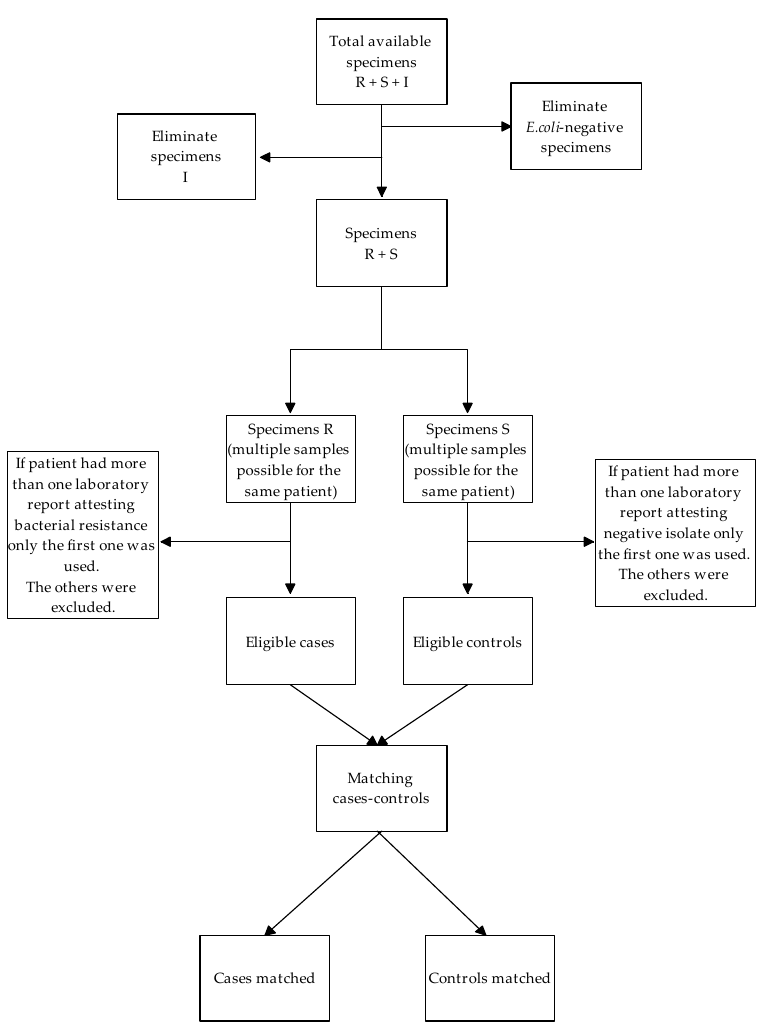
Figure 3. Flow diagram of included cases and controls. Abbreviations: R = 3GC-resistant specimens; S = 3GC-sensible specimens; I = 3GC-intermediate specimens.